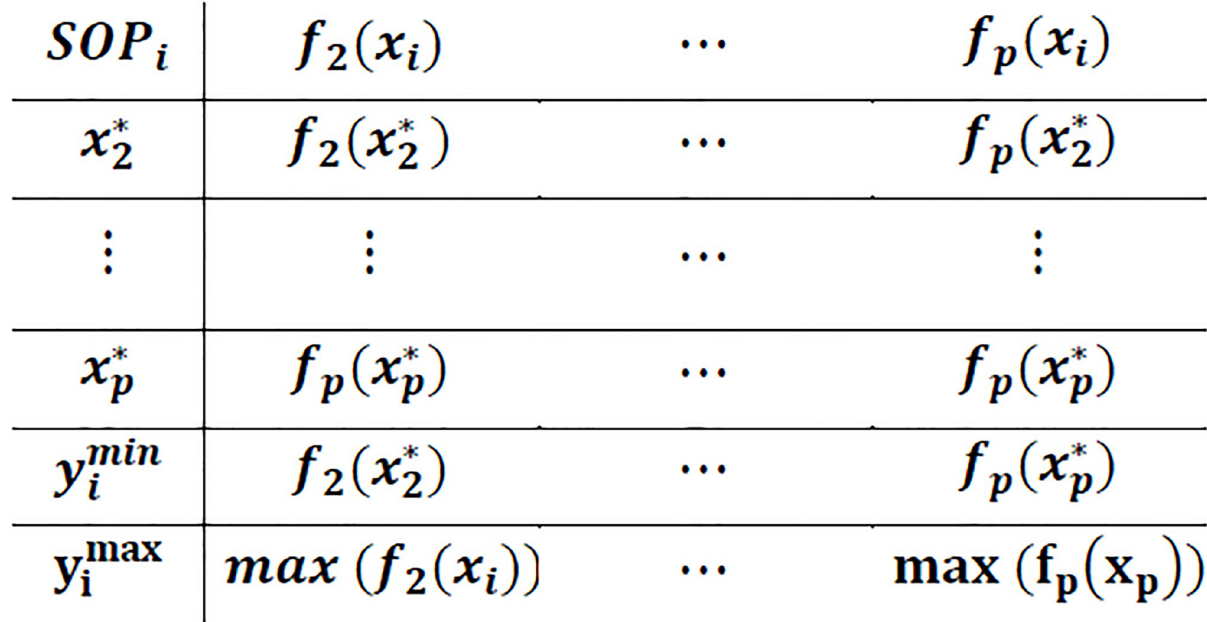
Fig 2. Structure of payoff table in the ε -constraint